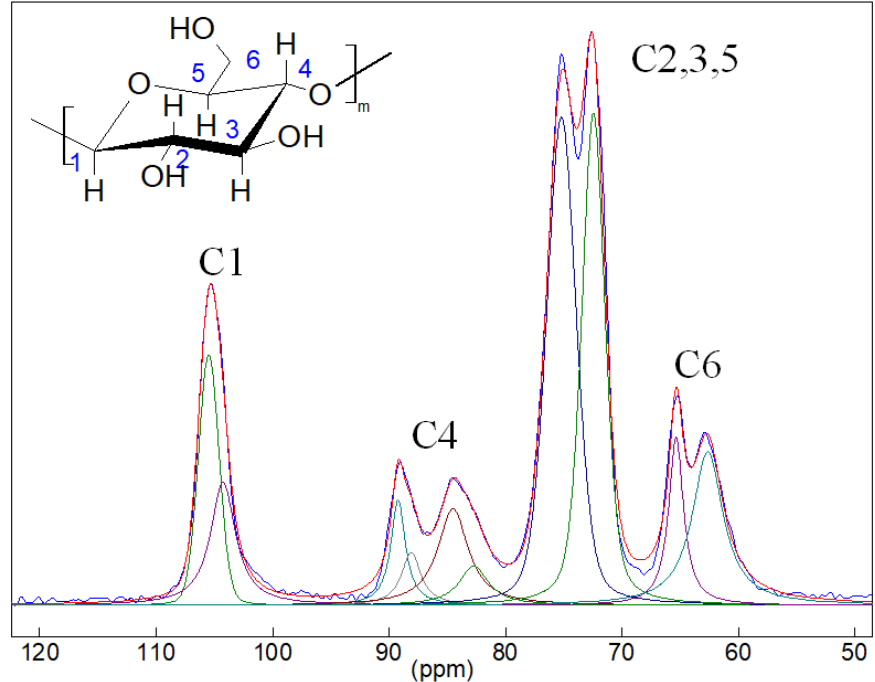
Figure 5. CP/MAS 13 C NMR spectrum of the HogC sample. The results of the description of the spectrum by 10 mixed Gauss/Lorentz functions are presented in Table 2. The inset shows the chemical structure of cellulose. Numbers indicate carbon atoms.